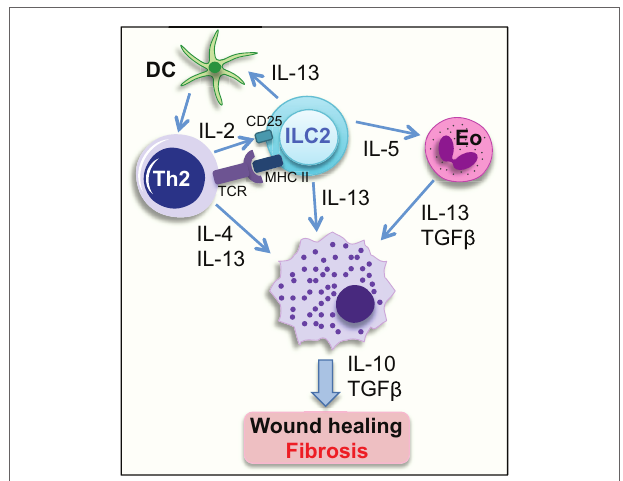
FiGURe 3 | Group 2 innate lymphoid cells can activate other cell types to initiate a wound-healing response . ILC2 can activate Th2 cells directly through interaction between MHC class II, expressed on the surface of ILC2, and the TCR on CD4 + Th2 cells, and indirectly via IL-13-mediated activation of DCs. IL-2 release from Th2 cells activates IL-13-producing ILC2s via interaction with CD25 expressed on ILC2. IL-5 release from ILC2 can activate eosinophils to release IL-13 and TGF β . IL-4 and IL-13 released from activated Th2 cells, and also ILC2- and eosinophil-derived IL-13 can activate tissue resident and infiltrating macrophages to initiate a wound-healing response, which if excessive, can result in the generation of a fibrotic lesion. Eo, eosinophil; DC, dendritic cell; TCR, T cell receptor; MHCII, major histocompatibility complex class